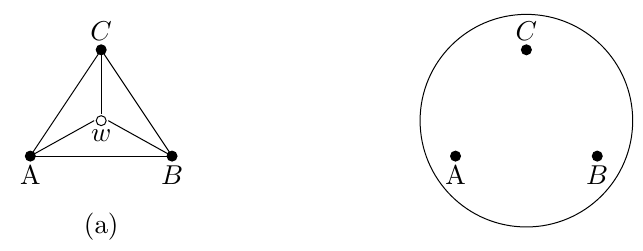
Figure 1 . (a) The interaction graph of a Hamiltonian, H , consisting only of two body interac- tions, whose low-energy e(cid:11)ective Hamiltonian approximates to high accuracy the 3-body interaction depicted in (b). The white vertex in (a) represents an ‘ancilla qubit’ | these don’t appear in the low- energy e(cid:11)ective Hamiltonian as they are projected into a one-dimensional subspace in this regime. Let H = (cid:1) 1 3 ( (cid:0) A + B ) 2 + ( A 2 + B 2 ) (cid:10) C 2